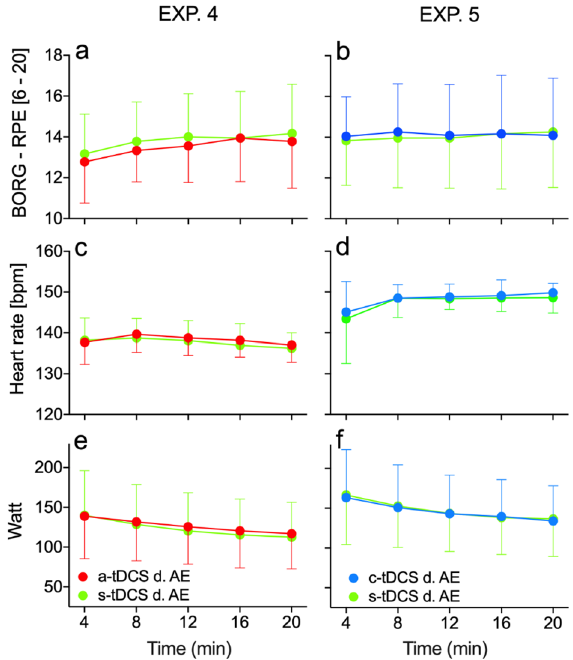
Figure 2. Exercise-related parameters RPE, HR, and Watt for EXP. 4 and EXP. 5 during the time course of the experiment. Presented are the mean values (error bar = SD) of the measuring points for BORG-RPE, heart rate, and Watt (pedal resistance) for EXP 4 ( a , c , e ) and 5 ( b , d , f ). Figure drawn with GraphPad Prism version